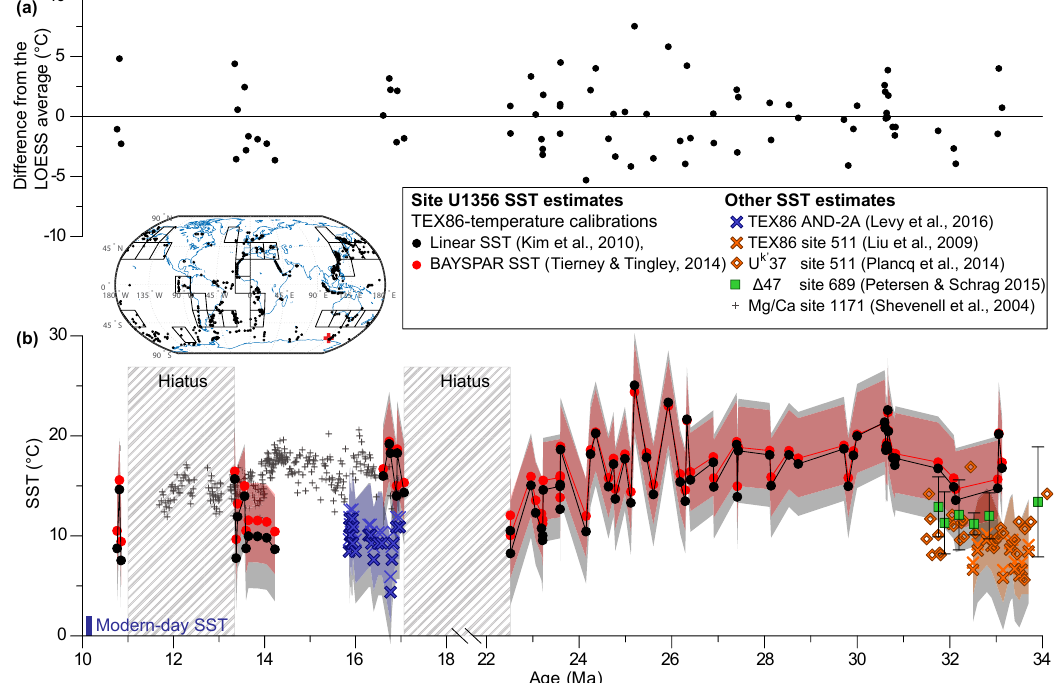
Figure 3. (a) TEX 86 -based SSTs plotted against age (Ma), using the linear calibration of Kim et al. (2010) and the BAYSPAR method (see text). The map (center left) indicates the 20 ◦ × 20 ◦ grid cells from which core-top values (black dots) were obtained for the BAYSPAR calibration. The red + in the map indicates the location of Site U1356. Other SST estimates are plotted for comparison. For the TEX 86 - based temperature estimates (blue and orange crosses), the symbols with both fill and outline are based on the linear calibration of Kim et al. (2010); those with the fill color only are based on the BAYSPAR SST calibration (Tierney and Tingley, 2014). The standard error of the Kim et al. (2010) calibration is indicated by grey shading and the standard error of the BAYSPAR calibration is indicated by colored shading. (b) The SST difference from the LOESS average based on the linear calibration of Kim et al. (2010) plotted against age. Modern-day temperature range indicated along the y